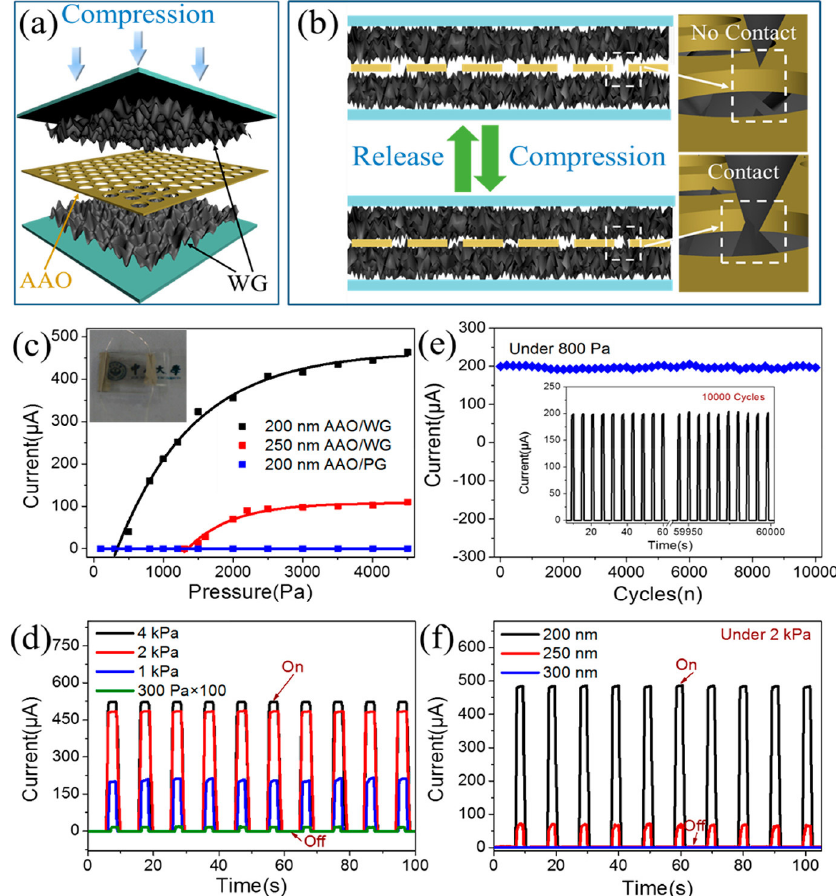
Figure 39. Schematics illustration of the PAA/Graphene device and current responses of pressure sensors. ( a ) Structural and ( b ) operating schematics of the pressure sensor. ( c ) Current response of different pressure sensors under various pressures. Inset is the photograph of packaged pressure sensor with silver electrodes. ( d ) Cyclic current responses of pressure sensors based on 200-nm-thick AAO membrane and WG under various pressures. The cyclic current response of the pressure sensor under 300 € was multiplied by 100. ( e ) Stability measurement of pressure sensors based on 200-nm-thick AAO membrane and WG. ( f ) Cyclic current responses of pressure sensors based on PAA membrane with different thickness and WG. Reprinted with permission from Ref. [208]. Copyright